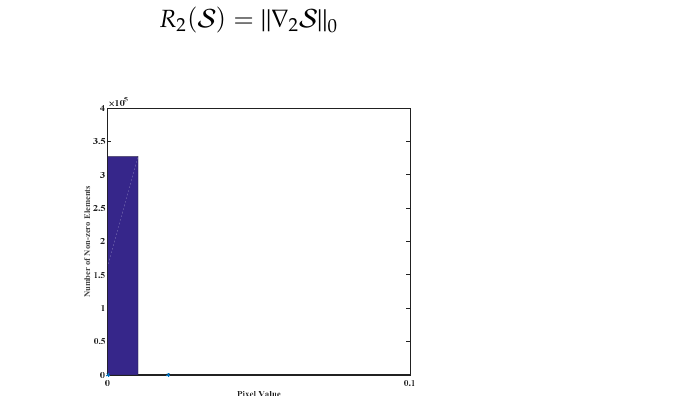
Figure 2. Statistics of non-zero elements in ∇ 2 S . Vertical axis indicates the number of non-zero elements, while horizontal axis represents pixel